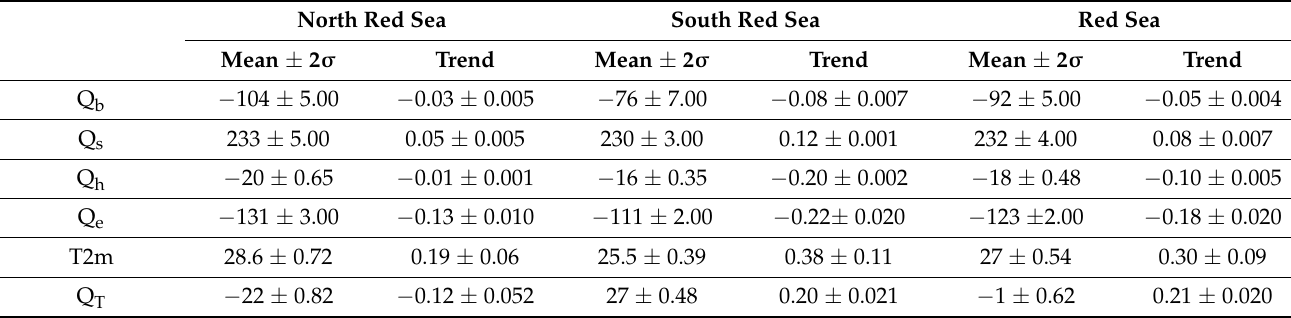
Table 1. Mean net heat flux (Q T = Q b + Q s + Q h + Q e ) in W/m 2 and air temperature at 2 m elevation (T2m) in ( ◦ C) with standard deviation ( ± 2 σ , W/m 2 ) and trends [(W/m 2 )/yr) and ( ◦ C/decade)] for the North, South, and whole Red Sea from 1981 to 2020.